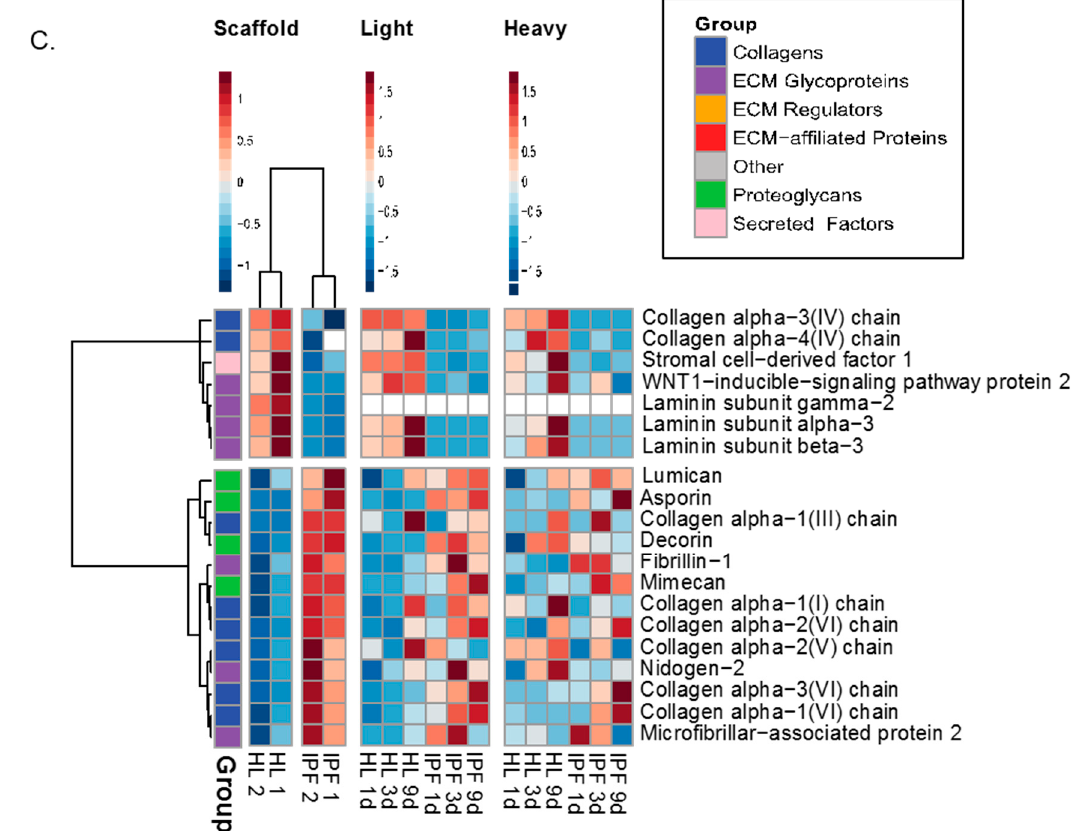
Figure 4. Proteomic characterization of matrisome proteins in tissue sca ff olds repopulated with SILAC labelled fibroblasts. ( A ) Spearman correlations of matrisome proteins in repopulated healthy and IPF sca ff olds at day 1, 3, and 9 after repopulation. Sca ff old group mean MS-intensities for each time point presented (biological replicates n = 4, technical replicates n = 2). ( B ) Statistics for matrisome groups for repopulated healthy and IPF sca ff olds over time calculated from summed matrisome groups. Student’s t -test with Benjamin–Hochberg corrected p -values for significance between patient groups of the same time point with p -values * p < 0.05, ** p < 0.01. Light # p = 0.089 (Secreted Factors). ( C ) Heatmap of matrisome proteins over time. Unsupervised hierarchical clustering of Z-scored values (ward.D2). Sca ff olds are presented as patient means (biological replicate n = 2) and repopulated sca ff olds (light and heavy) are presented as patient group mean intensities for each time point ( n = 4) with technical replicates for each group ( n = 2). Light and heavy intensities were selected and visualized according to previous sca ff old